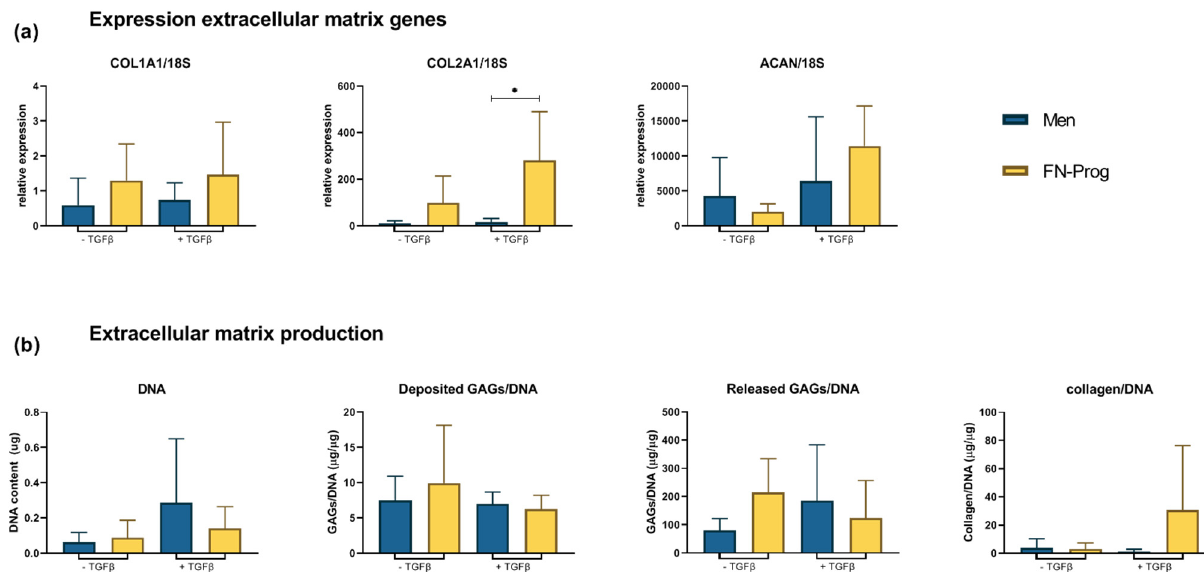
Figure 4. ( a ) Expression of genes associated with meniscus extracellular matrix production, and ( b ) DNA content, glycosaminoglycan deposition and release normalized for DNA content and collagen deposition measured by hydroxyproline assay, normalized for DNA content after 28 days of pellet culture in chondropermissive medium in absence or presence of TGF- β 1. n = 5 donors per group per condition. ACAN , aggrecan; COL1A1 , collagen type I α 1 chain; COL2A1 , collagen type II α 1 chain; GAG, glycosaminoglycan; TGF β , transforming growth factor beta 1; * p < 0.05.